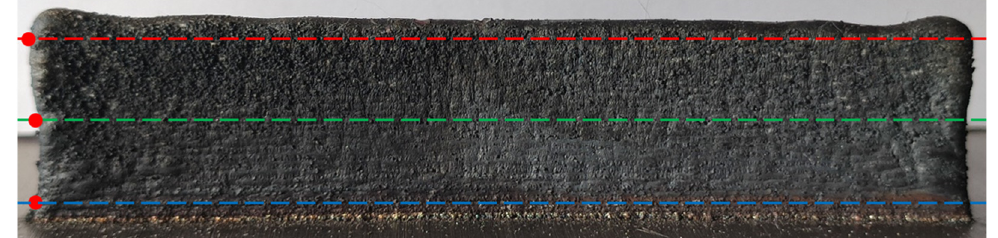
Figure 4. The 316L stainless steel thin-walled parts formed by laser cladding: ( a ) Processing process; ( b ) side morphology; ( c ) dimensions of thin-walled parts; ( d ) morphology of one end of the thin- walled parts.